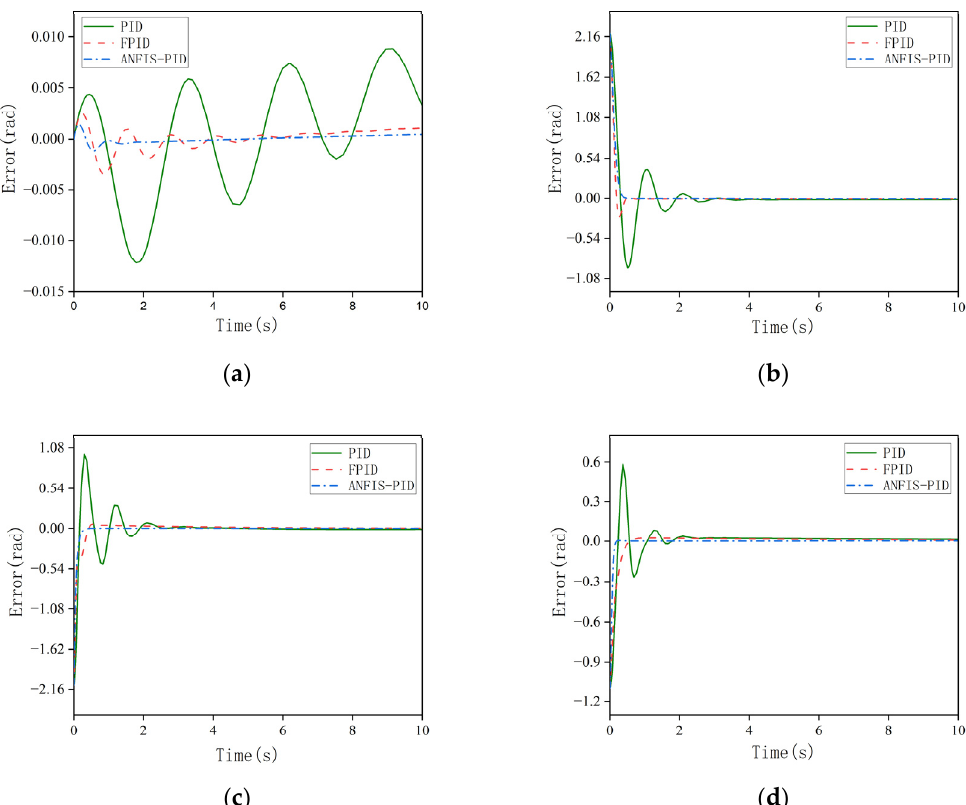
Figure 11. ( a ) Angular displacement error for joint 1; ( b ) angular displacement error for joint 2; ( c ) angular displacement error for joint 3; ( d ) angular displacement error for joint 4.